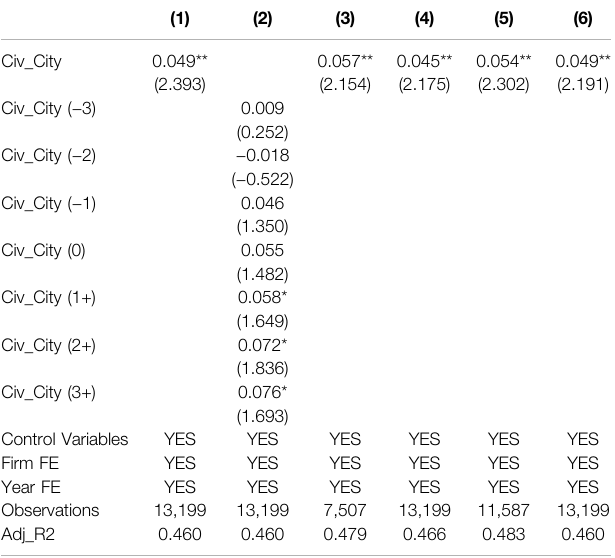
TABLE 1 | The impact of civilized cities on corporate ESG